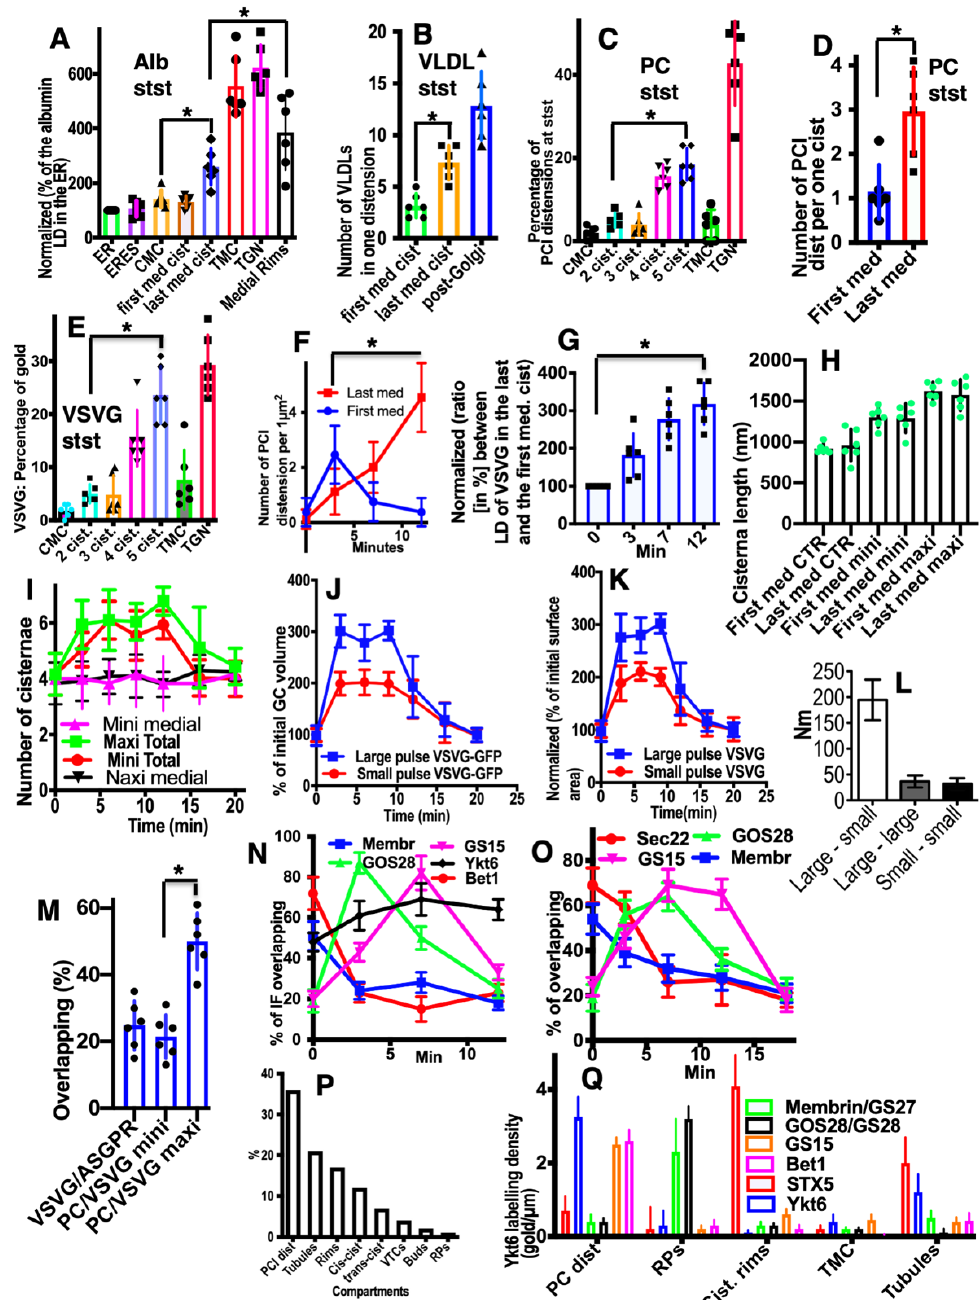
Figure 4. Quantification of data. ( A – E ) Steady-state (stst). Normalised (versus the ER) gold labelling of albumin ( A ) and VSVG ( E ). Normalised (versus the first medial cisterna) number of VLDLs in one cisternal distension ( B ). Normalised number of procollagen I-containing distensions in one cisterna ( C , D ). ( A ) Gold labelling for albumin in the last medial cisterna and the trans -most cisterna is significantly higher than that in the first medial cisterna ( p < 0.05). ( B ) The number of VLDLs in one cisternal distension of the last medial cisterna is significantly higher than that in the first medial cisterna ( p < 0.05). ( C ) Distribution of PCI distension within the Golgi complex. Its proportion in the last medial cisterna is significantly higher than that in the first medial cisterna ( p < 0.05). ( D ) The numerical density of PC distensions in the last medial cisterna is significantly higher than that in the first medial cisterna ( p < 0.05). ( E ) Distribution of VSVG gold labelling within the Golgi complex. The numeric density of gold in the last medial cisterna is significantly higher than in the first medial cisterna ( p < 0.05). ( F ) The mini-wave. The number of PCI distensions per 1 µm 2 of cisterna. Their maximal number in the last medial cisterna is significantly higher than in the first medial cisterna ( p < 0.05). ( G ) Labelling for VSVG becomes significantly enriched in the last medial cisterna ( p <